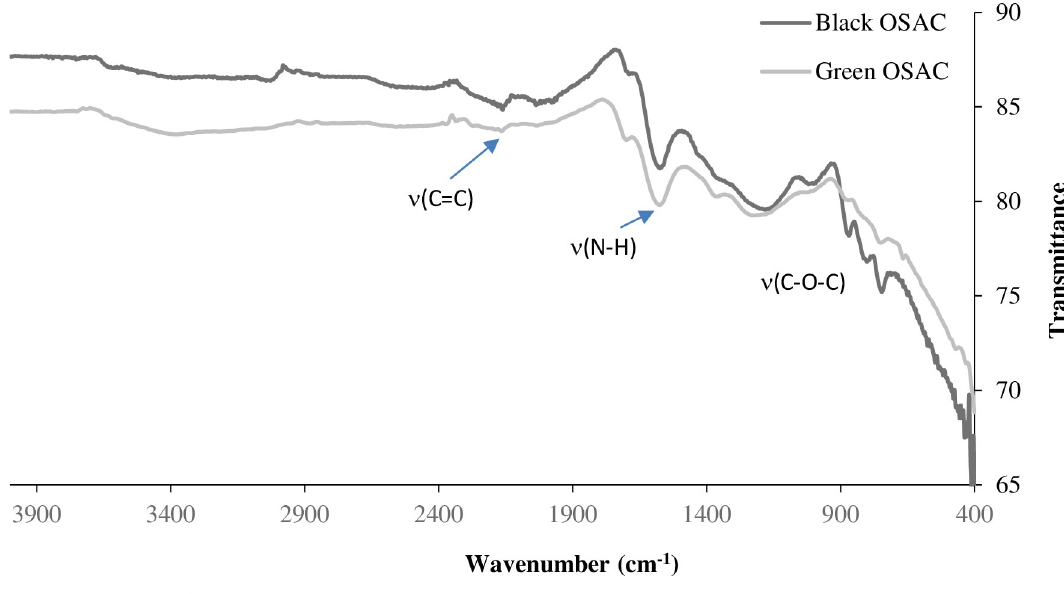
Fig 3. FTIR spectra of black OSAC and green